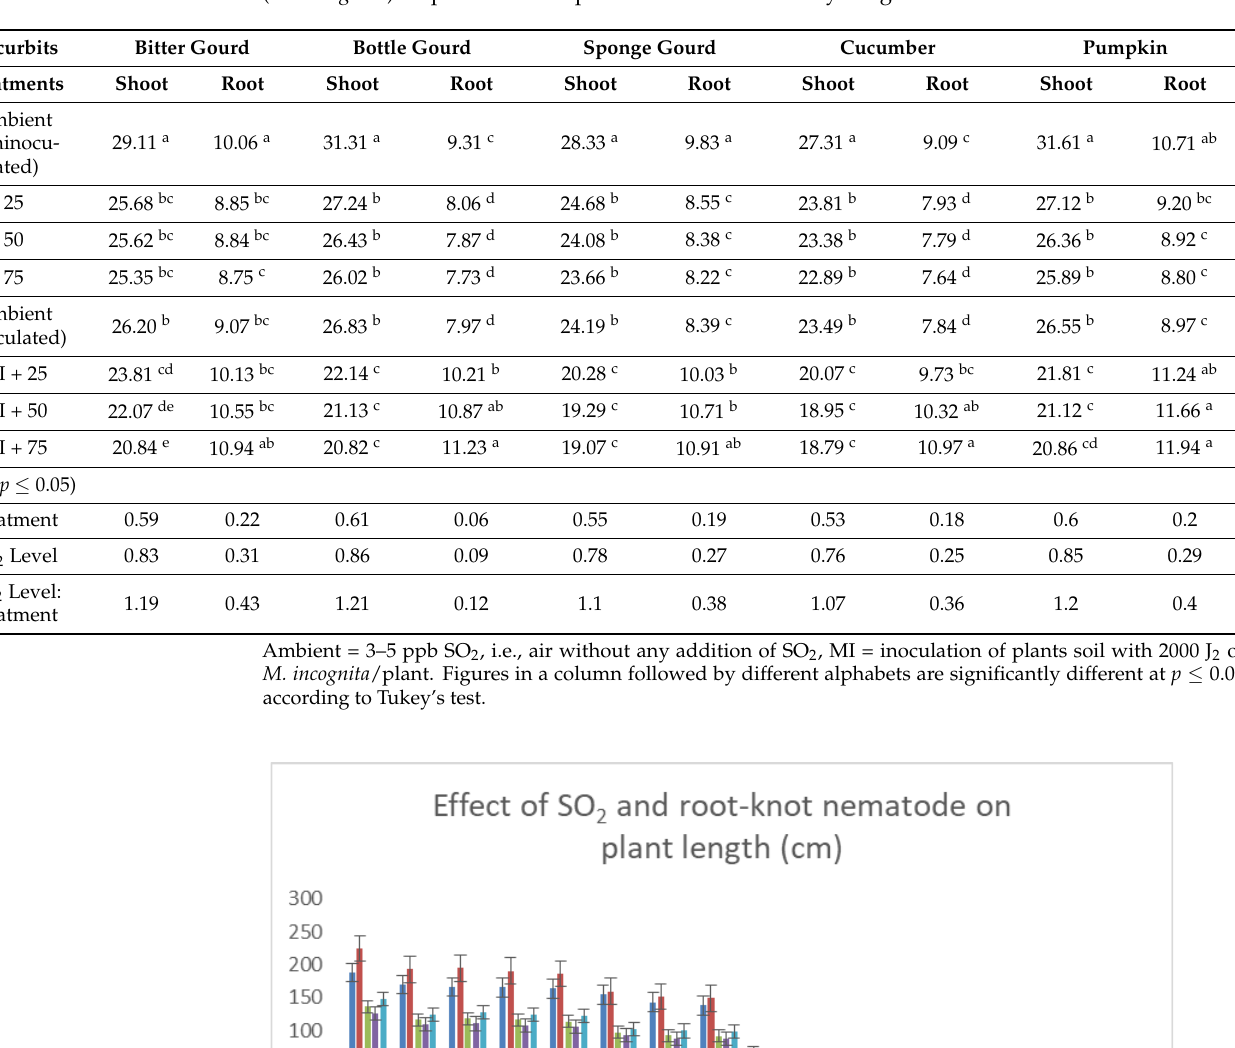
Table 2. Effect of intermittent exposures of SO 2 (ambient, 25, 50, and 75 ppb) and root-knot disease ( M. incognita ) on plant biomass production in terms of dry weight of the five cucurbits.